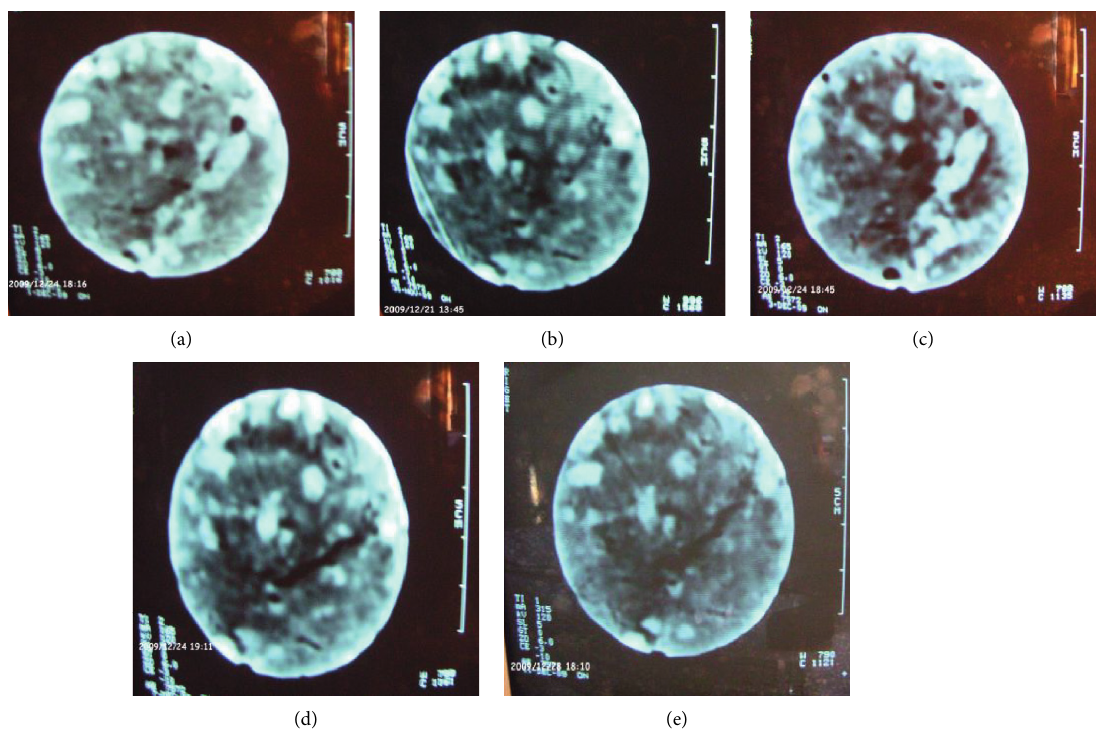
Figure 17: CT images of the b section position of the LC-2 sample with cycle amplitude Δ w � 20%. (a) Zero cycles. (b) One cycle. (c) Two cycles. (d) Four cycles. (e) Six cycles.